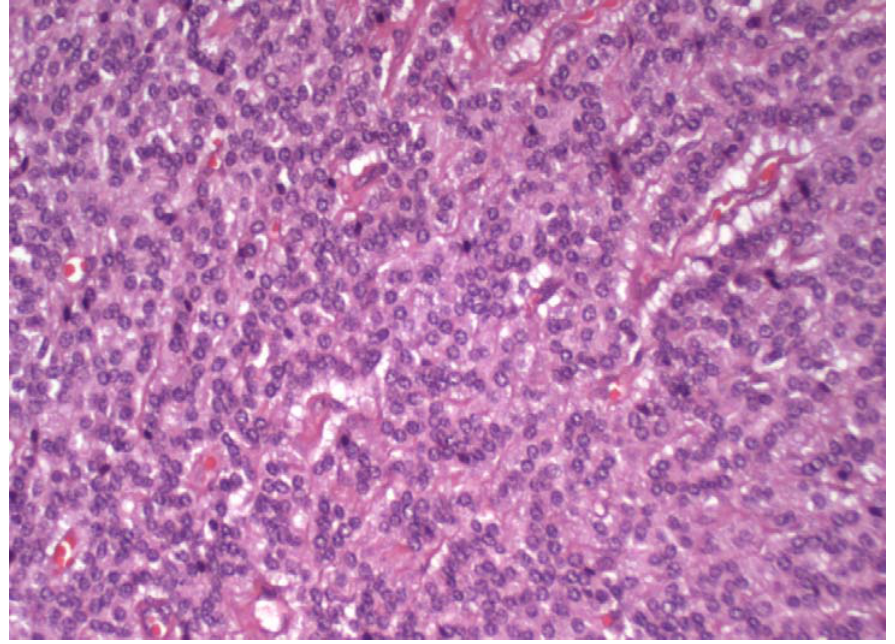
FIGURE 2 . Microscopic section showing uniform small round cells in a trabecular pattern (Hematoxylin and eosin stain).